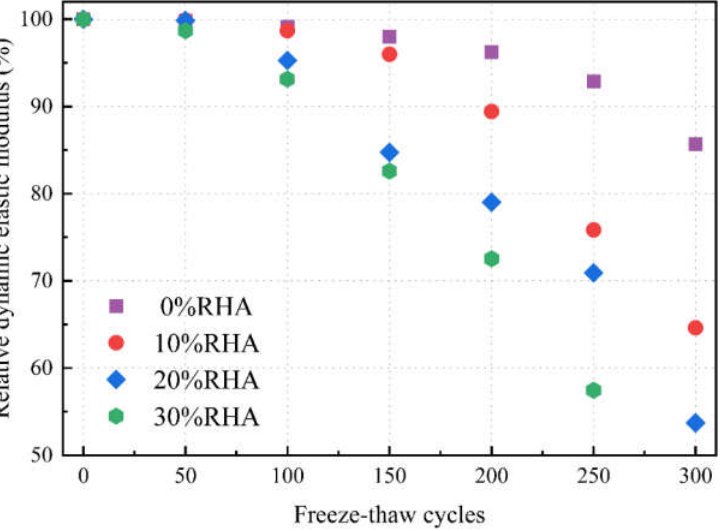
Figure 7. The relationship between the relative dynamic elastic modulus of recycled concrete and the number of freeze–thaw cycles with different RHA replacement